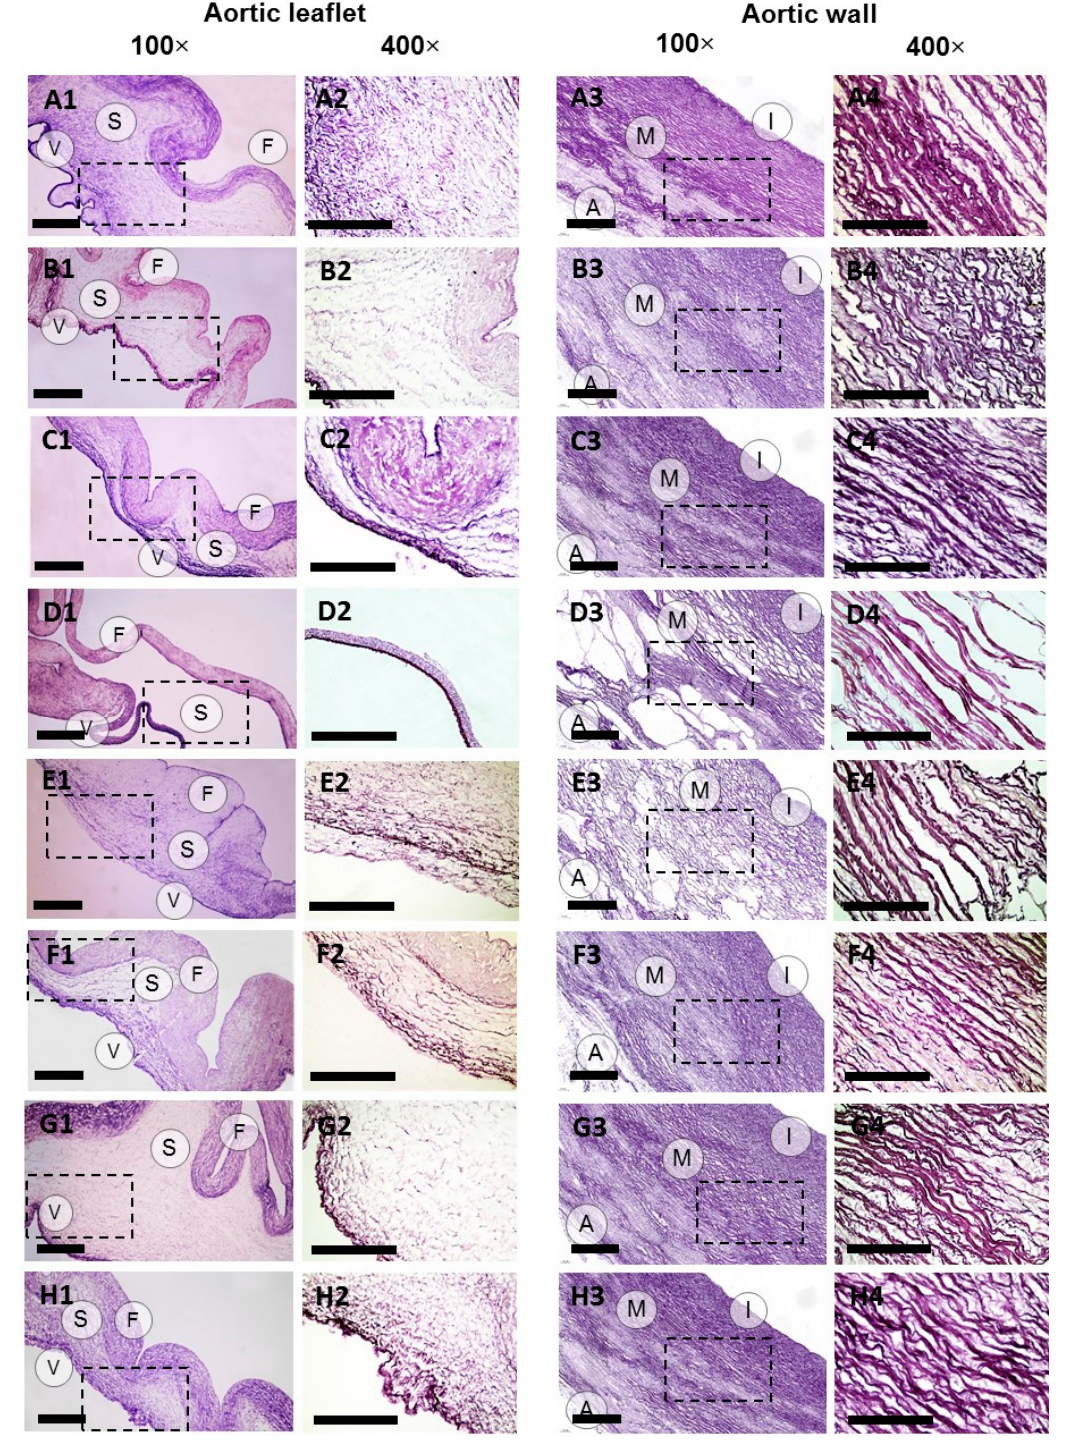
Figure 3. Elastin content in aortic valve leaflets and walls of native ( A1–4 ) and decellularized ovine aortic roots. Decellularization protocols included scCO 2 -assisted processing at the pressure of 15 MPa ( B1–4 ) and 25 MPa ( C1–4 ) with the use of ethanol as a co-solvent; combinations of alkaline treatment with scCO 2 -assisted processing at the pressure of 10 MPa ( D1–4 ) and 15 MPa ( E1–4 ); detergents alone ( F1–4 ) or with following scCO 2 treatment at the pressure of 15 MPa ( G1–4 ) and 25 MPa ( H1–4 ). Weigert staining. Dashed lines mark the areas where the 400 × images were acquired. 100 × scale bar = 100 µ m; 400 × scale bar = 300 µ m.